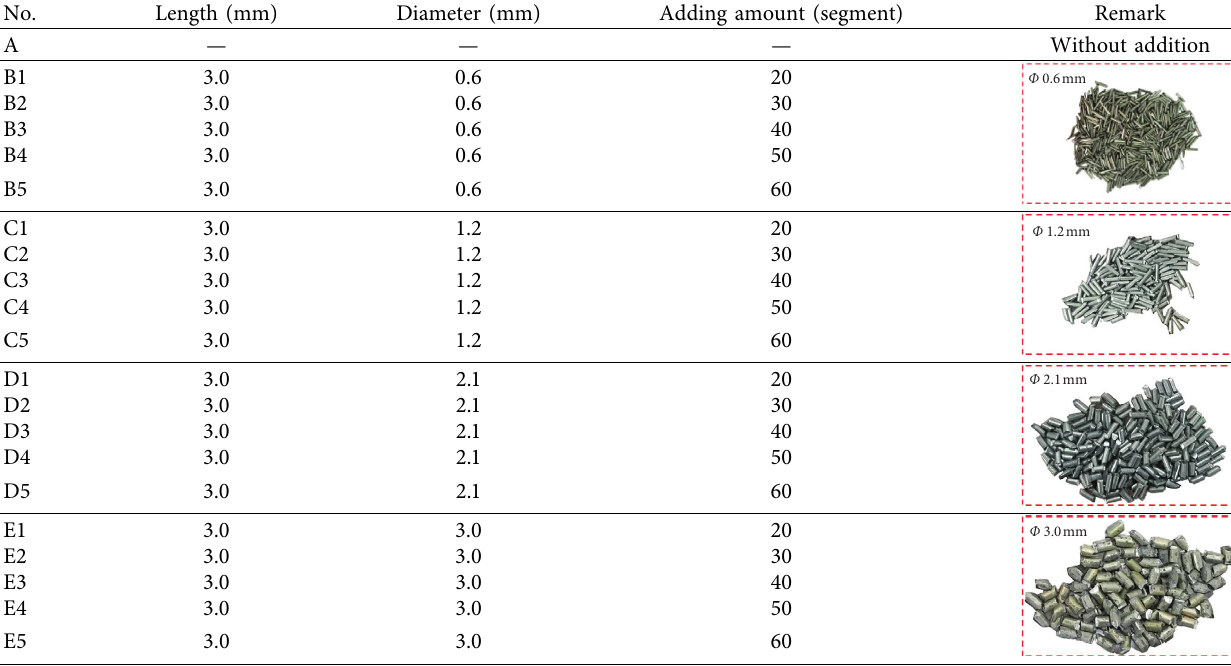
Table 4: Experiment design for steel segment of varying diameter and adding